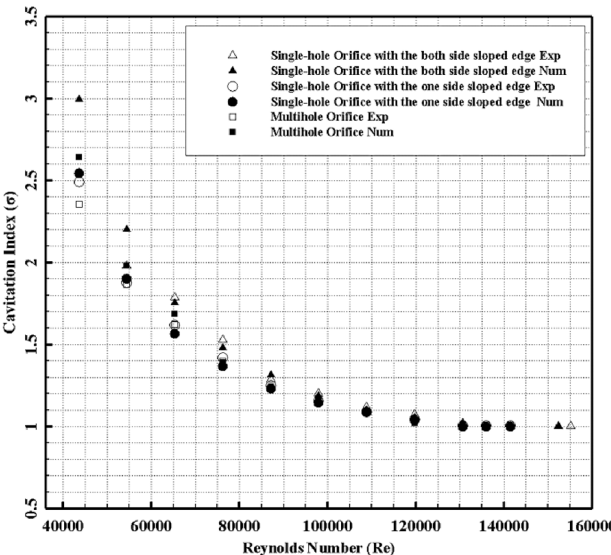
Fig. 19. Comparison of the resulted cavitation index trends as a function of the Re in the numerical and experimental analysis for ori fi ces with the same EDR of 0.4 including: 1- a single ­ -hole ori fi ce with a two-sided sloped edge, 2- a single-hole ori fi ce with a one-sided sloped edge, and 3- a multi-hole ori fi ce.